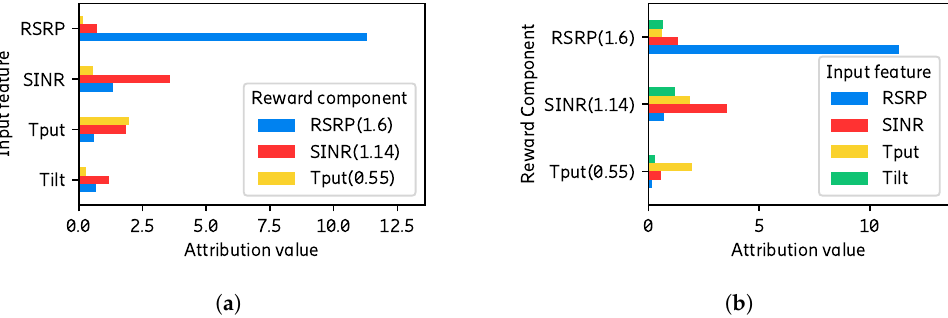
Figure 11. Explanations generated using BEERL at the RL level after the weights of the reward components (shown in parentheses) are adjusted. ( a ) Decomposed feature importance at the RL level. ( b ) Decomposed feature importance presented per reward component at the RL level. Table 2. Base value for each action and reward component at the RL level after the reward weights are adjusted to reduce the bias of the reward